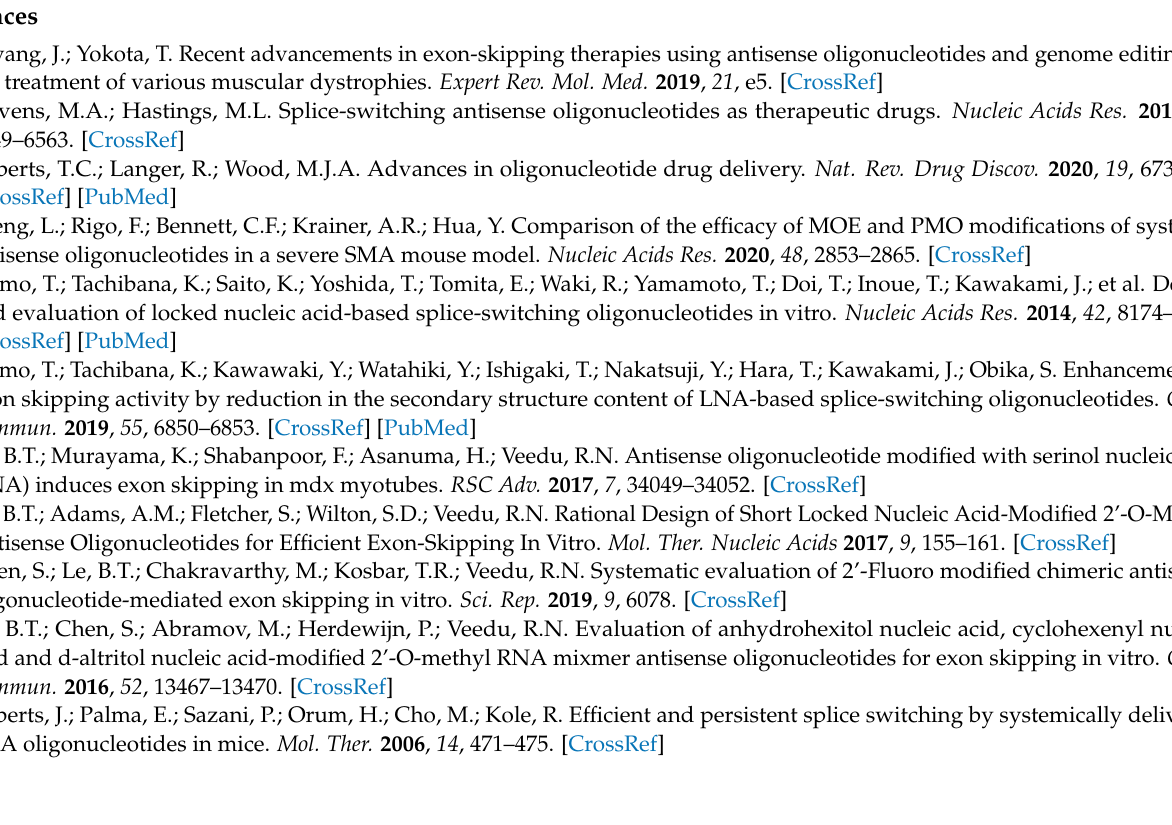
DMD exon 50 having different modification content, Figure S5: UV melting analysis for 21-mer Figure S6: Evaluation of LNA/AmNA/GuNA-modified SSOs for DMD exon 50 skipping at mRNA levels in DMD model cells, Table S1: LNA/AmNA/GuNA/2 (cid:48) -OMe RNA-based SSOs targeting DMD exon 58 used for the experiment, Table S2: Complementary RNA used for UV melting analysis of SSOs targeting DMD exon 58, Table S3: LNA/AmNA/GuNA/2 (cid:48) -OMe RNA-based SSOs targeting DMD exon 50 used for the experiment, Table S4: Complementary RNA used for UV melting analysis of SSOs targeting DMD exon 50, Table S5: 21-mer BNA-based SSOs targeting DMD exon 50 used for the experiment, Table S6: Complementary RNA used for UV melting analysis of 21-mer SSOs targeting DMD exon 50, Table S7: Primers used for RT-PCR analysis investigating DMD exon 50 skipping, Table S8: Primers used for quantitative PCR analysis investigating DMD exon 58 skipping, Table S9: Primers used for quantitative PCR analysis investigating DMD exon 50 skipping, Table S10: LNA-based SSOs used for target selection of DMD exon